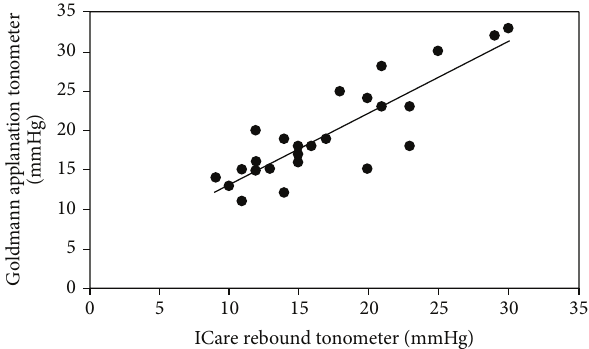
Figure 1: Comparative IOP using Goldmann applanation tonome- ter and ICare for seated patients. Correlation coefficient =